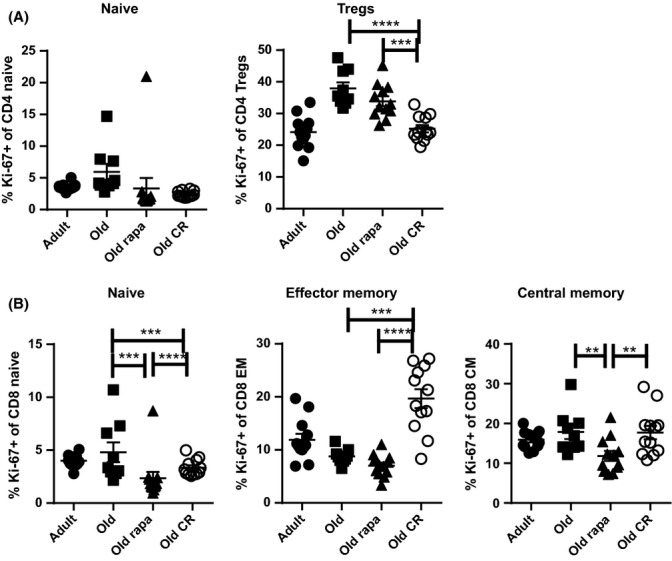
Rapamycin and calorie restriction differently alter T-cell subset steady-state proliferation. Steady-state proliferation was evaluated by Ki-67 staining within naïve, effector memory, and central memory CD8 T-cell subsets. (A) The frequency of cells within the naïve CD4 T-cell subset or within regulatory Tregs that are Ki-67+. (B) The frequency of cells within the indicated CD8 T-cell subsets that were Ki-67+. Data are shown as mean ± SEM and are representative of 3 independent cohorts. Statistical differences between O groups were calculated by 1-way ANOVA with Bonferroni post-tests. Adults are shown only to provide a young reference point and were not included in statistical analyses. *P<0.05; **P<0.01; ***P<0.001.